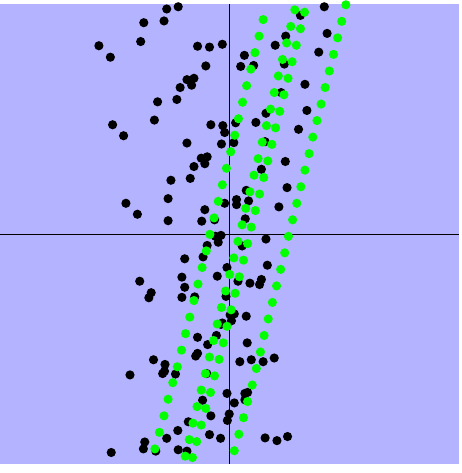
Figure 2. Example of a surface patch, approximate size 1 km × 1 km. The black dots are laser altimetry points of an ascend- ing ICESat track while green dots are from the descending repeat track. The surface patch is located at the crossover of ascend- ing/descending